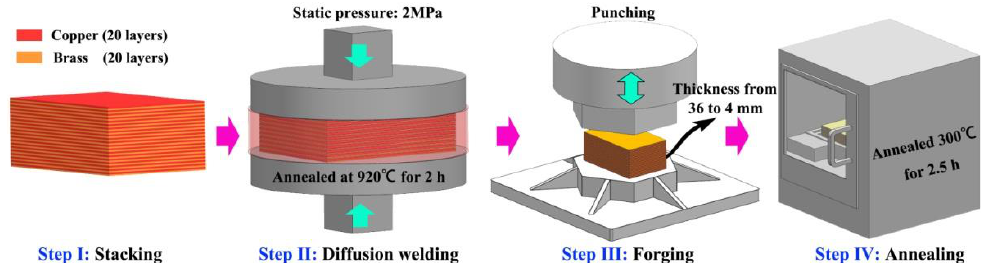
Figure 1. A schematic illustration of the fabrication of a multilayered soft – hard copper – brass block. It is noted that the related processing parameters are included in this figure.